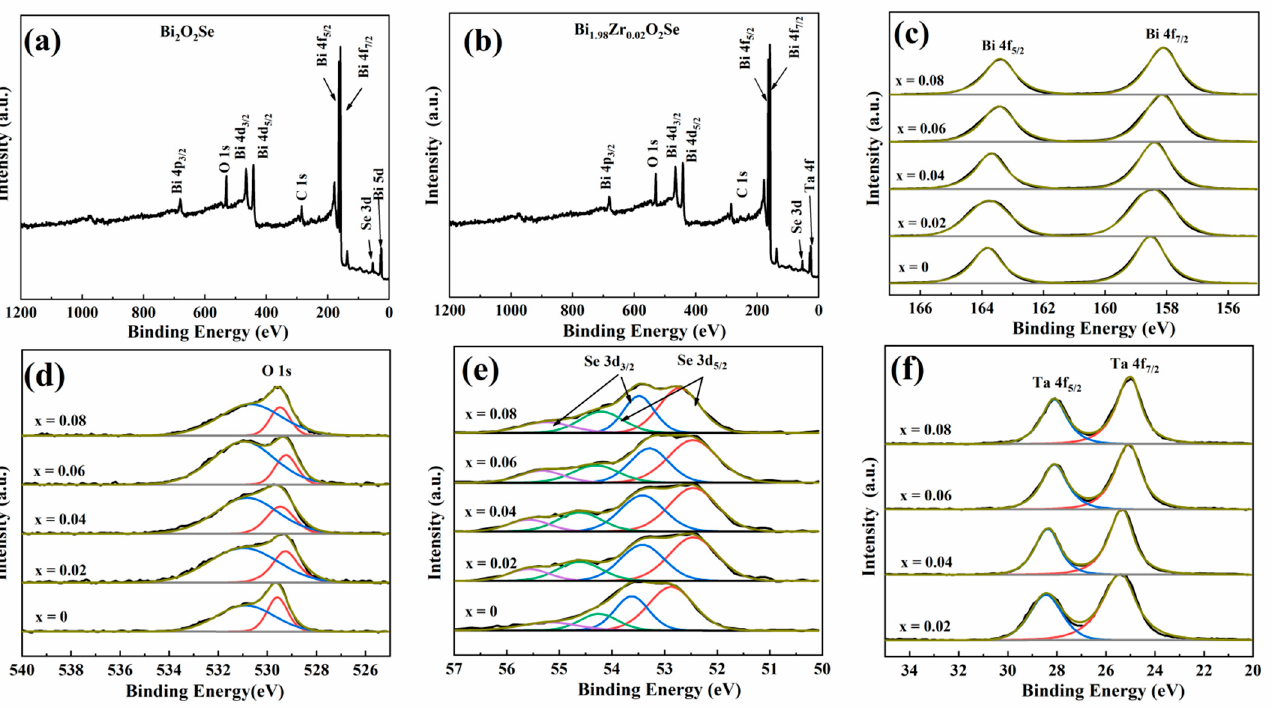
Figure 3. XPS survey spectrum of pure Bi 2 O 2 Se ( a ) and Bi 1.98 Ta 0.02 O 2 Se; ( b ) high-resolution spectra of ( c ) Bi 4f, ( d ) O 1s, ( e ) Se 3d, and ( f ) Ta 4f